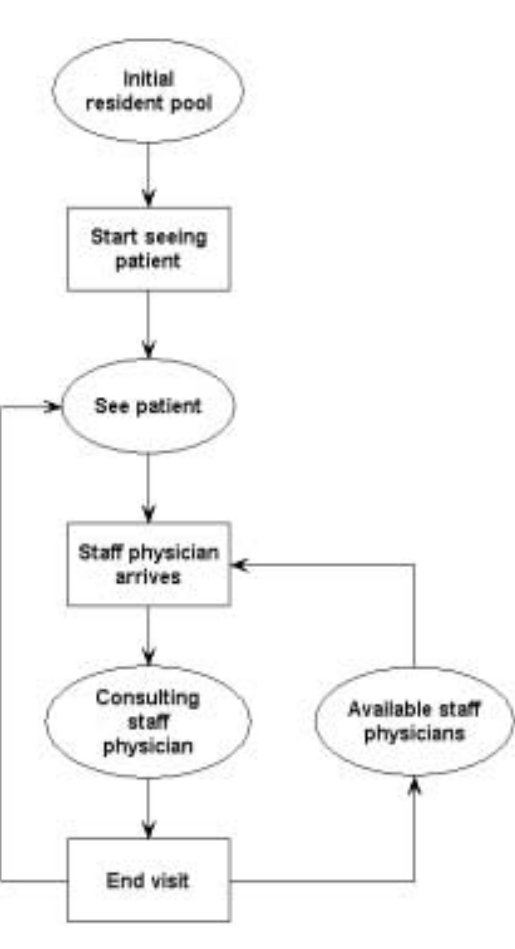
Coloured Petri Net model of an outpatient setting. The ellipses represent states (places) and the boxes represent ations